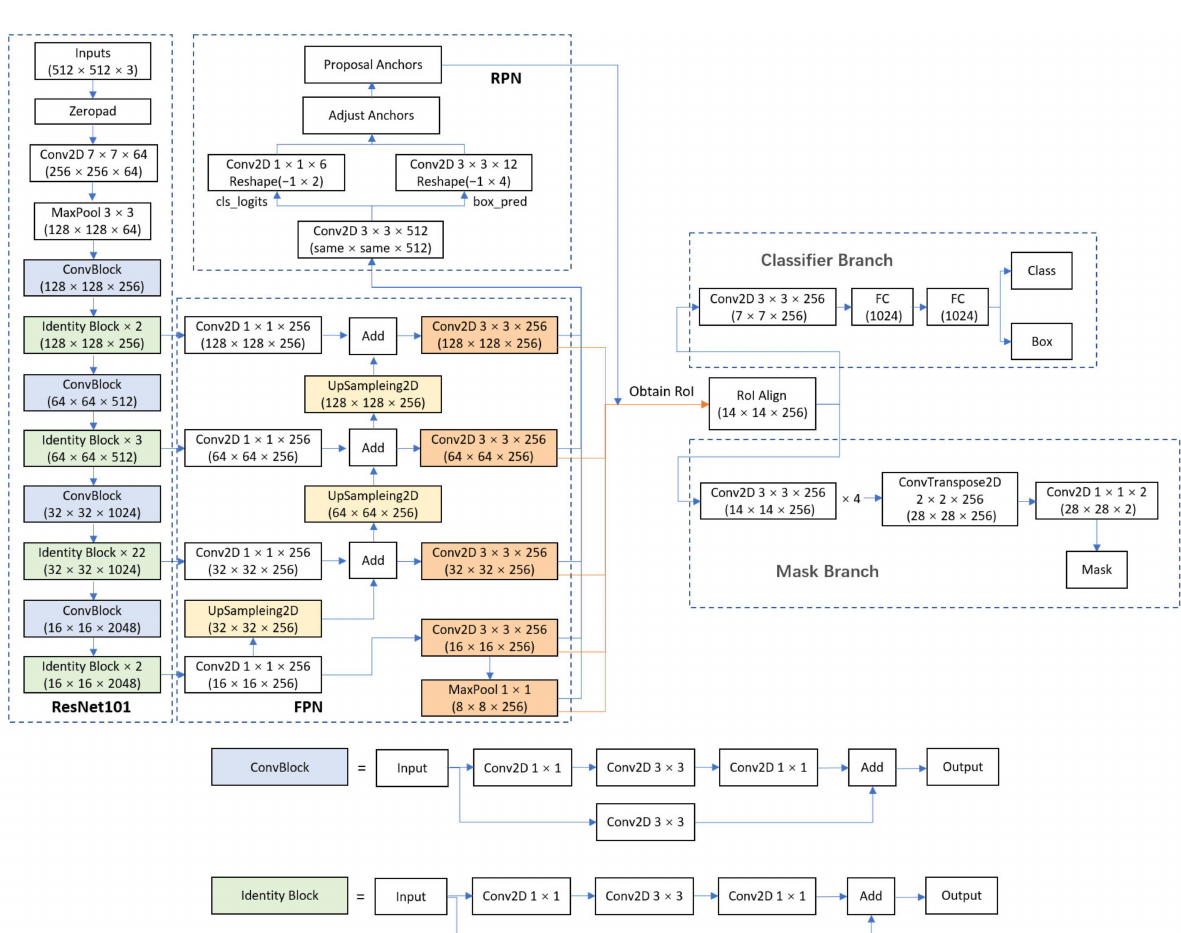
Figure 13. Detailed architecture of the Mask R-CNN used in this